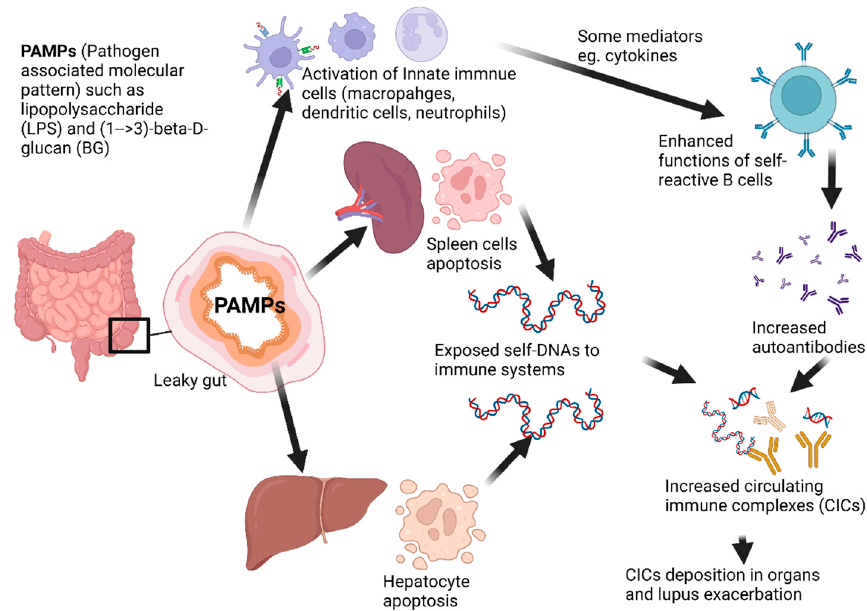
Figure 2. The working hypothesis diagram demonstrates the possible mechanism of leaky gut-ex- acerbated lupus through the elevated circulating immune complexes, from (i) increased exposure to the self-antigens from overwhelming apoptosis (such as splenocytes and hepatocytes) and (ii) enhanced autoantibody production from inflammatory mediators, due to the activation by PAMPs from leaky gut